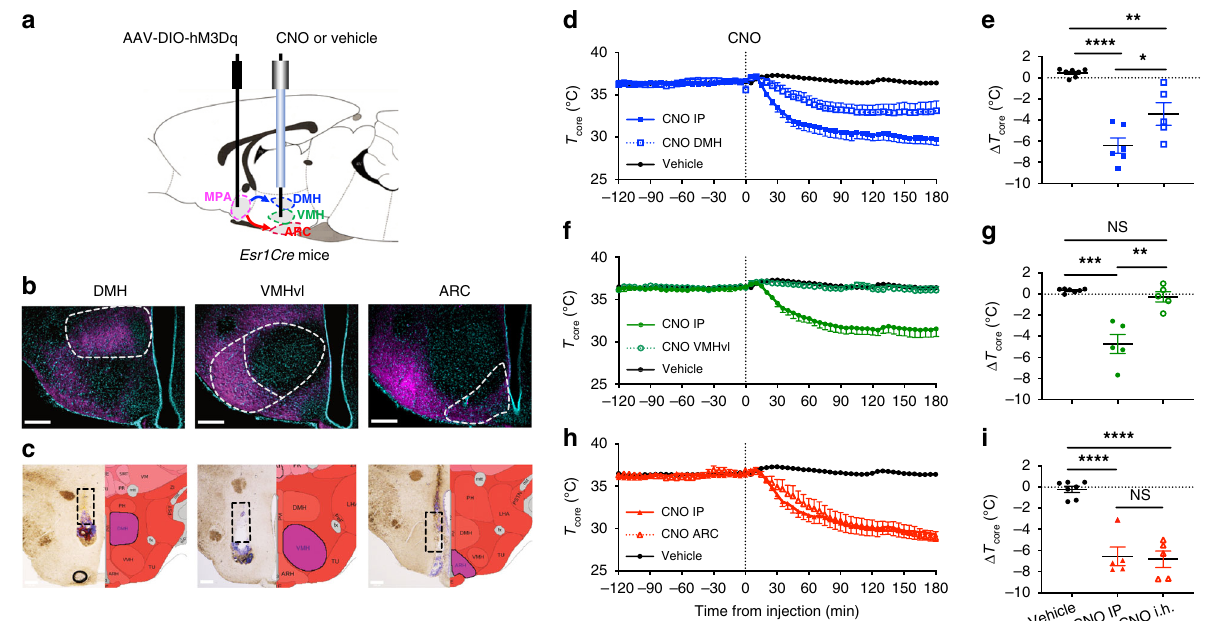
Fig. 5 Activation of estrogen-sensitive hypothalamic circuits drive decreases in core body temperature. a Schematic strategy for testing the thermoregulatory hypothalamic circuits from the MPA by intrahypothalamic (i.h.) delivery of CNO or vehicle (arti fi cial cerebrospinal fl uid, aCSF) to the projected nuclei. b mCherry fi bers indicating projections from MPA ER α + neurons to DMH (represtentative of n = 6 mice), VMHvl (representative of n = 5 mice), and ARC (representative of n = 5 mice). ARC arcuate nucleus, DMH dorsal medial hypothalamus, MPA medial preoptic area, VMHvl ventral lateral subregion of ventromedial hypothalamus. Scare bars: 250 µ m. c Bright fi eld coronal sections (left) and diagram coronal sections (right) showing the canular track and targeted nuclei for local CNO delivery. d , f , h Core temperature ( T core ) measured every 5 min before and after injection (dotted line at x = 0) of vehicle (saline and aCSF data combined, n = 7), CNO IP (0.3 mg/kg) or CNO i.h. (8.4 ng/mouse) in the DMH (blue, n = 6 mice shown in d and e ), VMH (green, n = 5 mice shown in f and g ), and ARC (red, n = 5 mice shown in h and i ). e , g , i Change in core temperature ( Δ T core ) after vehicle or CNO administration (120 min to 180 min after injection) compared to baseline ( − 120 min to 0 min before injection). Statistical signi fi cance denoted by NS, not signi fi cant; * p < 0.05; ** p < 0.01; p < 0.01; *** p < 0.001, and **** p < 0.0001 for posthoc two-tailed Tukey ’ s multiple comparisons test following a signi fi cant effect of treatment ( p < 0.0001) in a one-way